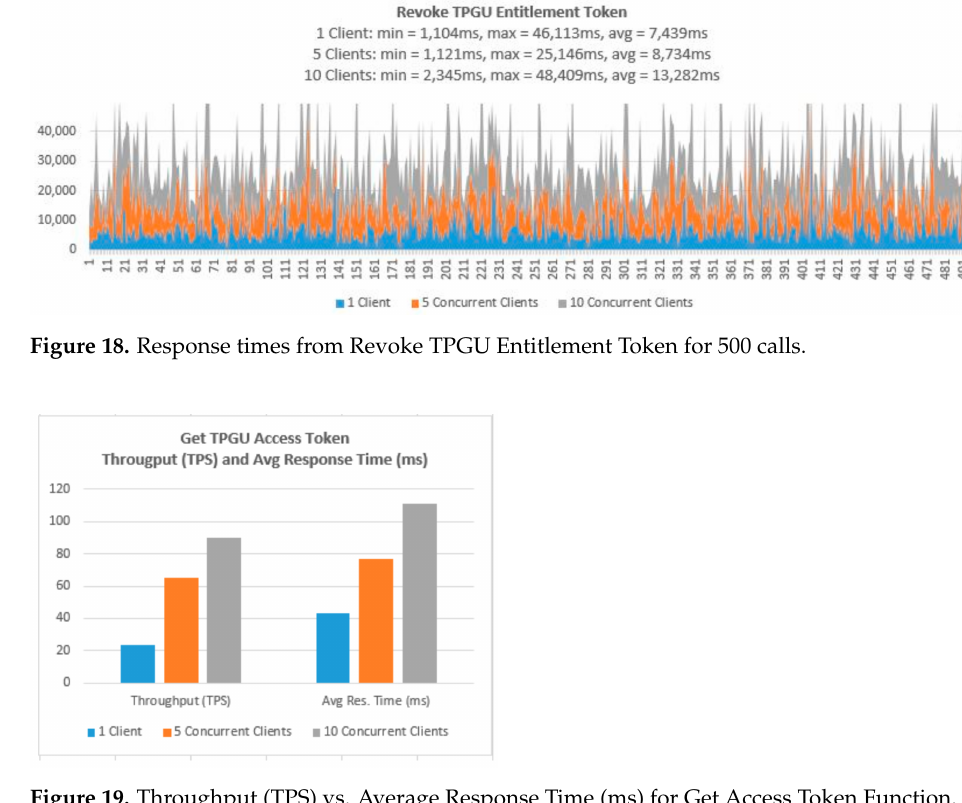
Figure 19. Throughput (TPS) vs. Average Response Time (ms) for Get Access Token